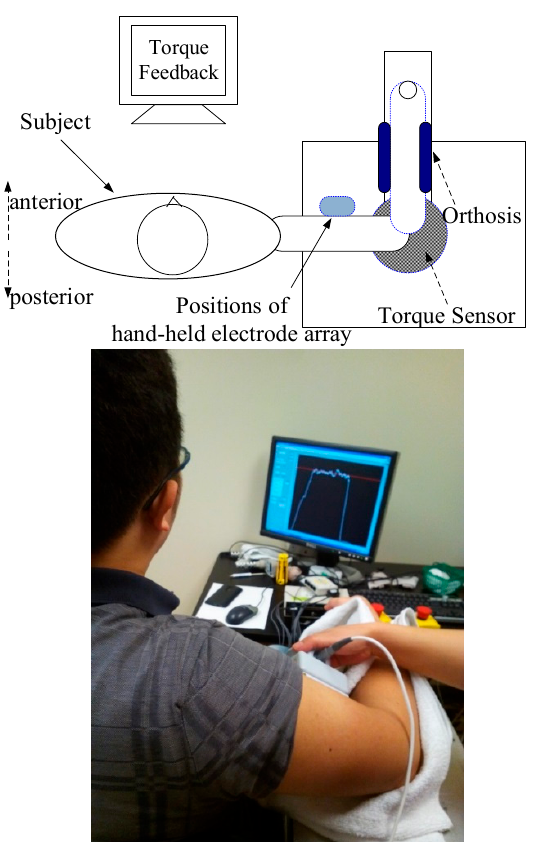
Figure 1. Experimental setup of EIM measurement during contraction.